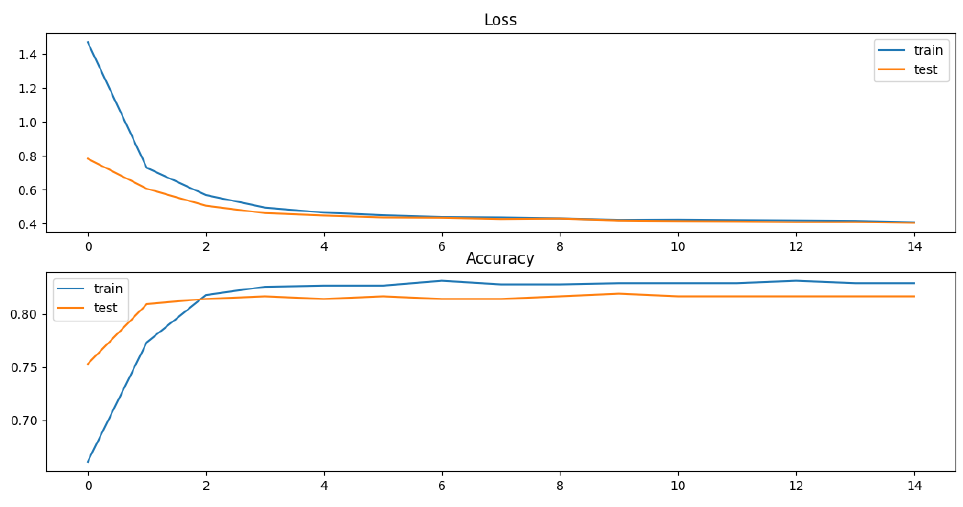
Figure 11. Evolution of accuracy and loss during training and validation phases. In the training phase, the training accuracy and training loss are equal to 0.832 and 0.408, respectively. In the test phase, the test accuracy and the test loss are equal to 0.816 and 0.403, respectively